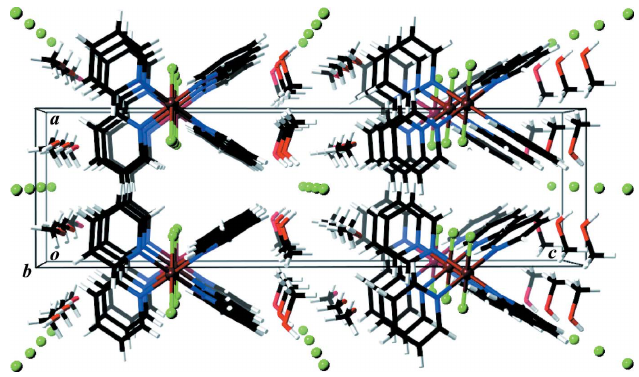
Figure 2 A packing diagram of the solvated title salt, in a view along the b axis. Colour code: purple, Rh; green, Cl; red, O; blue, N; black, C; and white, H.